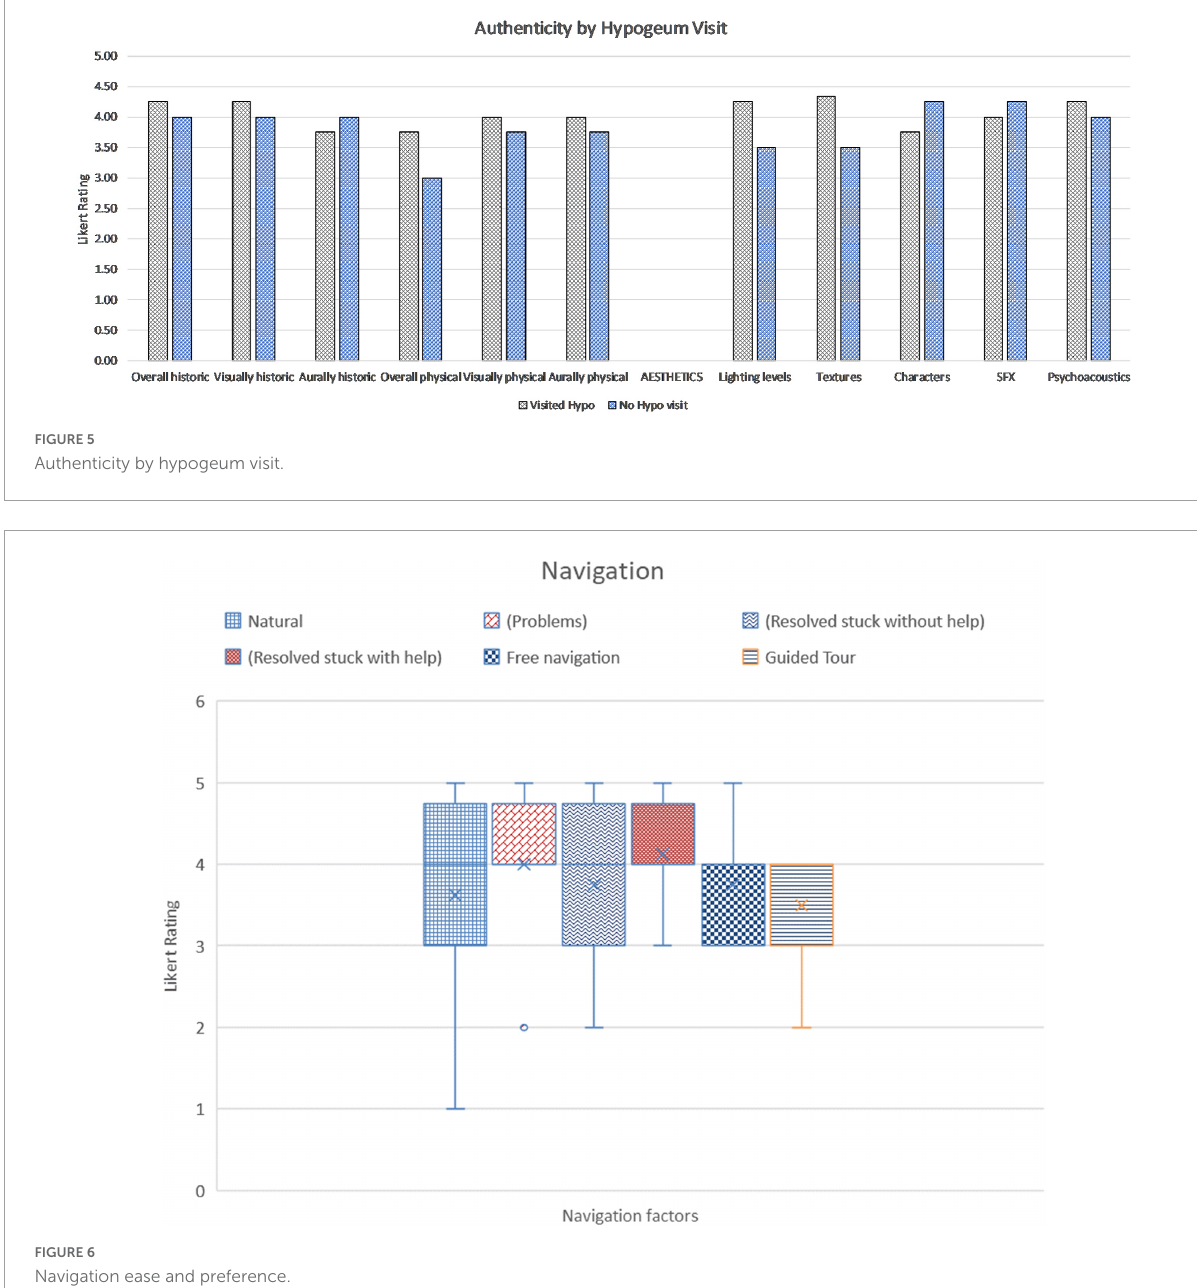
FIGURE6 Navigation ease and